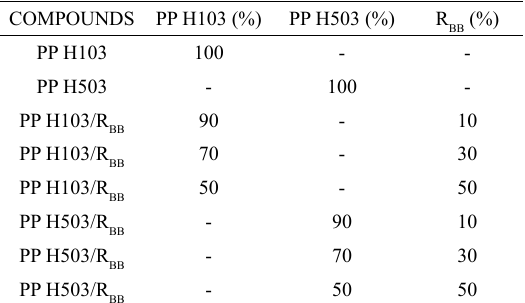
Table 1. Compounds processed in this work.